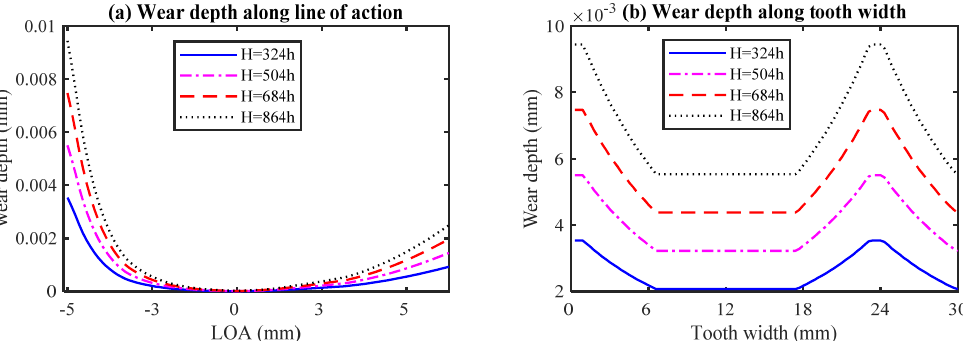
Figure 7. Maximum tooth wear depth under different running hours. ( a ) Wear depth along the line of action; ( b ) Wear depth along tooth width.